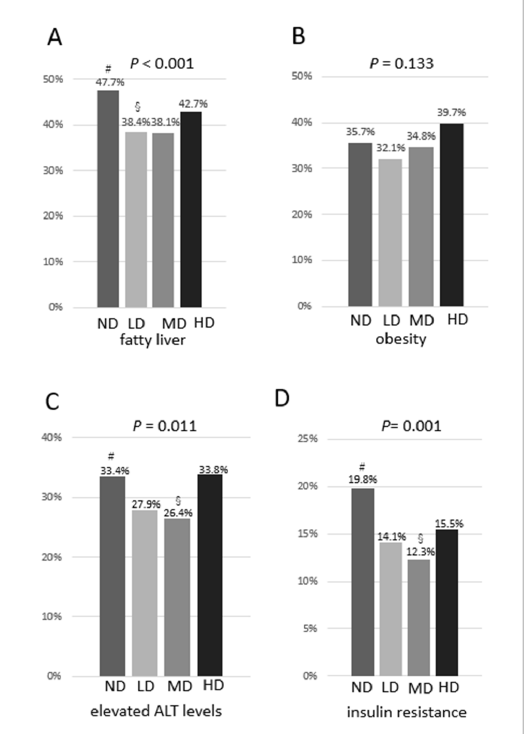
Figure 1. ( A ) Prevalence of fatty liver by categories of consumption of alcohol; ( B ) Prevalence of obesity Figure 1. ( a ) Prevalence of fatty liver by categories of consumption of alcohol; ( b ) Prevalence of obesity by categories of consumption of alcohol; ( C ) Prevalence of elevated levels of ALT by categories of by categories of consumption of alcohol; ( c ) Prevalence of elevated levels of ALT by categories of consumption of alcohol; ( d ) Prevalence of resistance to insulin by categories of consumption of consumption of alcohol; ( D ) Prevalence of resistance to insulin by categories of consumption of alcohol. alcohol. ＃ adjusted standardized residual > 1.96; § adjusted standardized residual < − 1.96 . #adjusted standardized residual > 1.96; § adjusted standardized residual < −